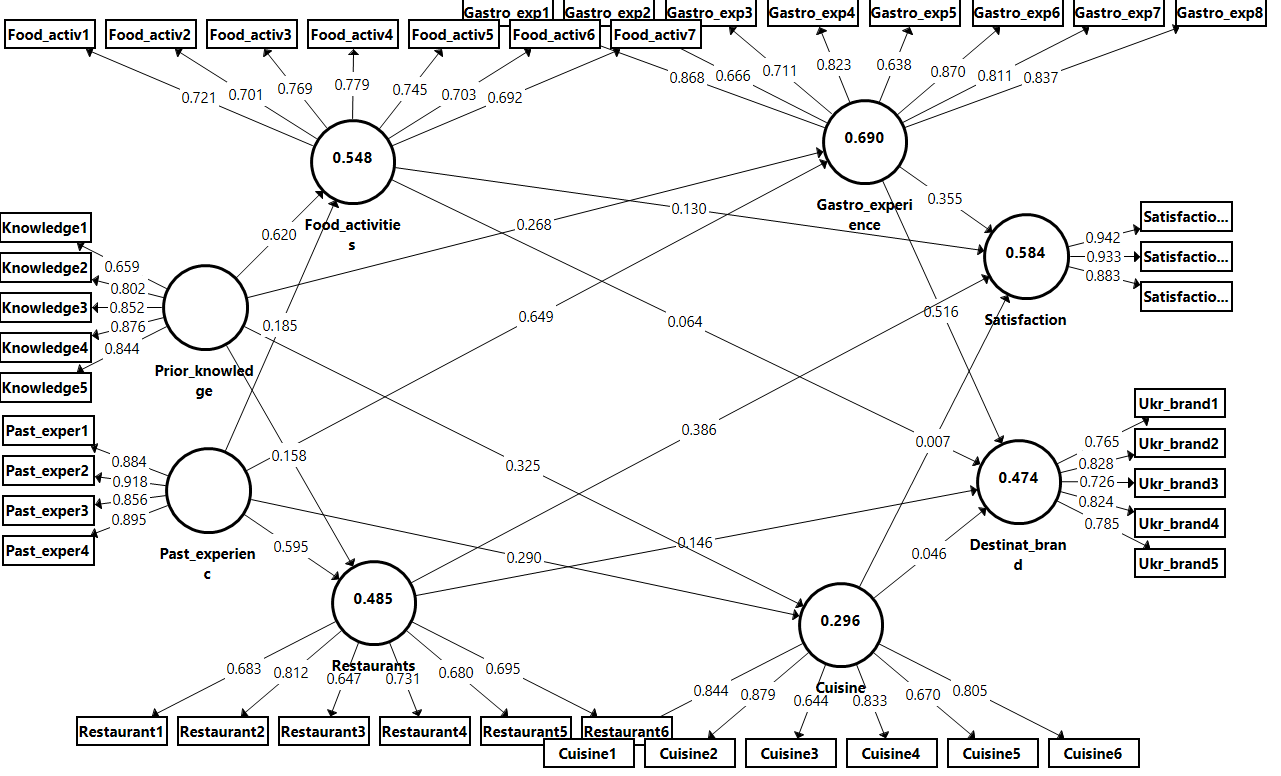
Figure 1. Structural model. Note: the circles represent the constructs or variables; the rectangles represent the items of the construct’s measurements, with the associated values for the standardized factor loadings; and the arrows represent the tested relationships between the constructs, with the beta values.